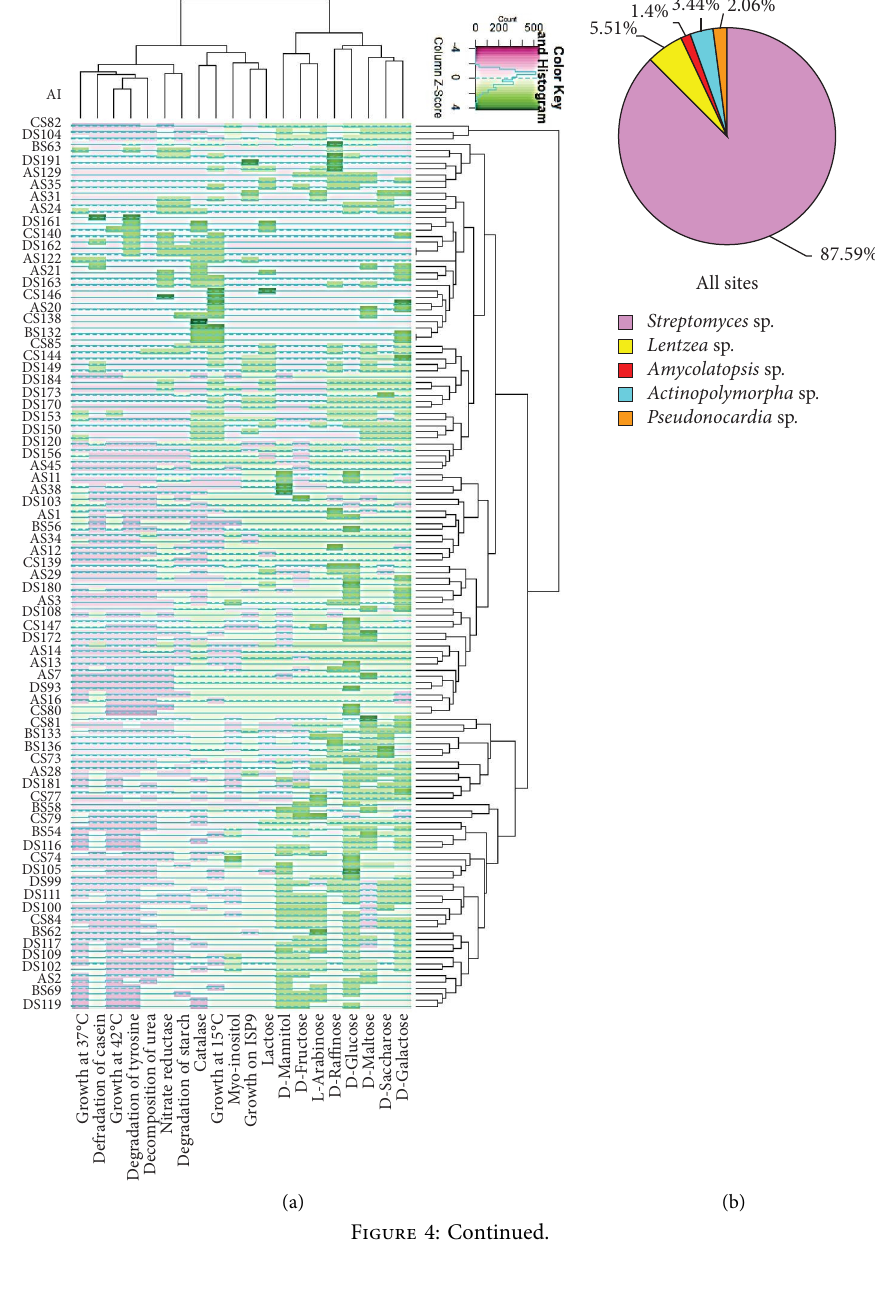
87.59%2.06%3.44%1.4% All sites Streptomyces sp . Lentzea sp . Amycolatopsis sp . Actinopolymorpha sp . Pseudonocardia sp